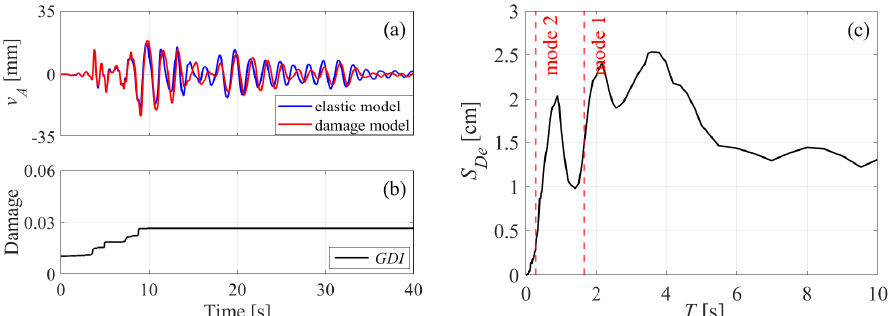
Figure 12. Earthquake T1212 station: ( a ) elastic and damage responses of the equivalent pier, ( b ) evolution of the GDI , ( c ) elastic displacement spectrum.